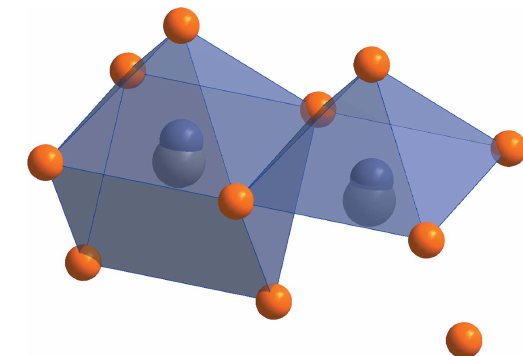
Figure 1 CuPbSb 3 Se 6 viewed down [001]. Pb and Pb/Sb are represented by grey, Sb by dark blue, Cu by cyan spheres of arbitrary radius.